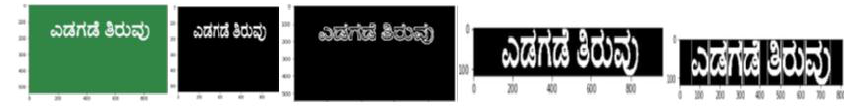
Fig. 7. Line wise segmentation of kannada text.